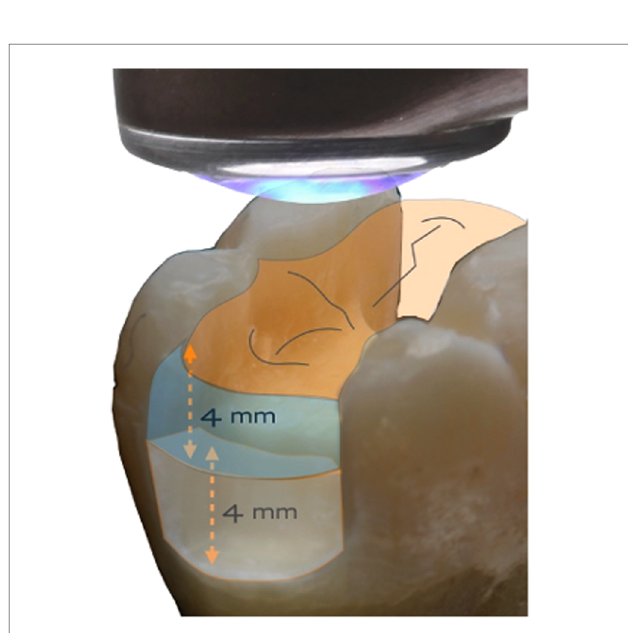
FIGURE 6 Even with direct contact of the light guide tip and the occlusal surface, there can be a fi nite distance to the proximal box.